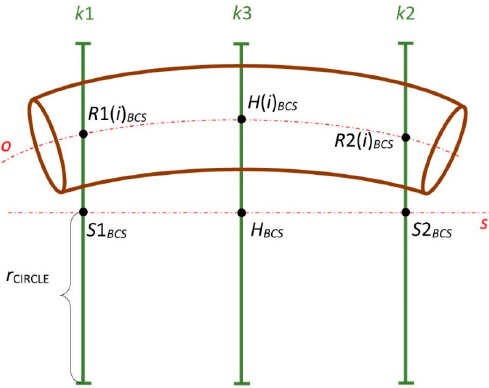
Figure 13. Schematic front view of collision test of non-bearing core frame passage through fiber-processing head (axis s BCS is parallel to axis y BCS